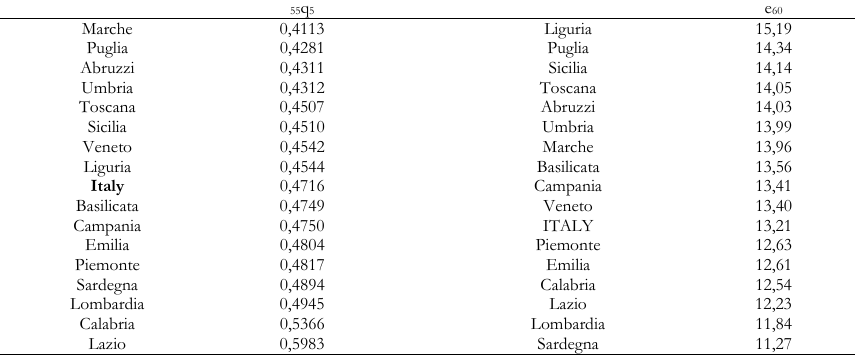
Distribution of Italian regions according to the values of 55 q 5 , and e 60 drawn from 1881-82 life tables (both